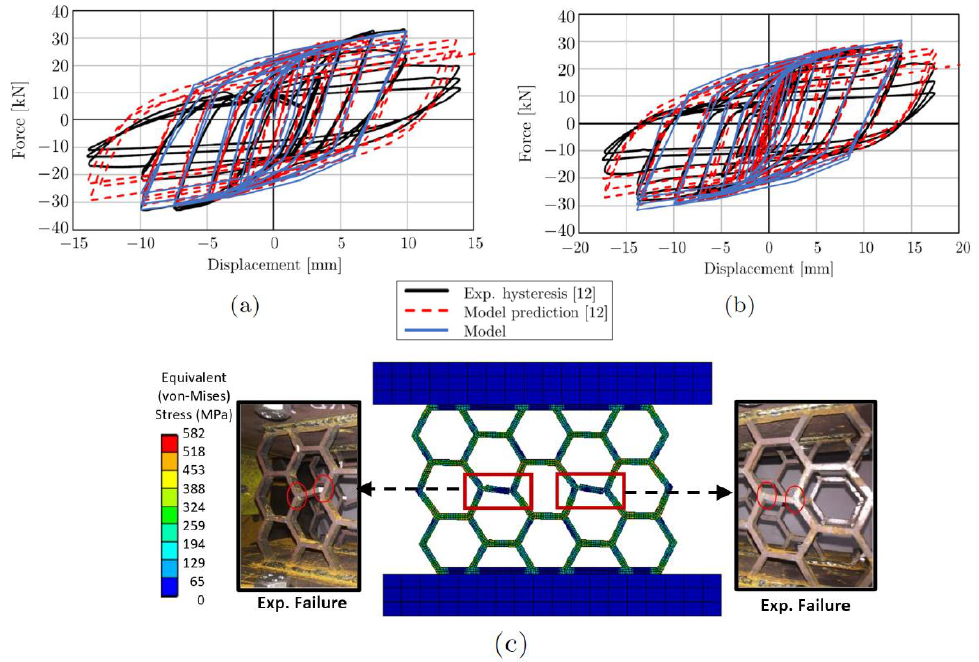
Figure 3. Model validation. Comparison of load–displacement hysteresis curves from models and experiments of ( a ) HHSD n°1 and ( b ) HHSD n°7 and ( c ) comparison of fracture zones of HHSD model and